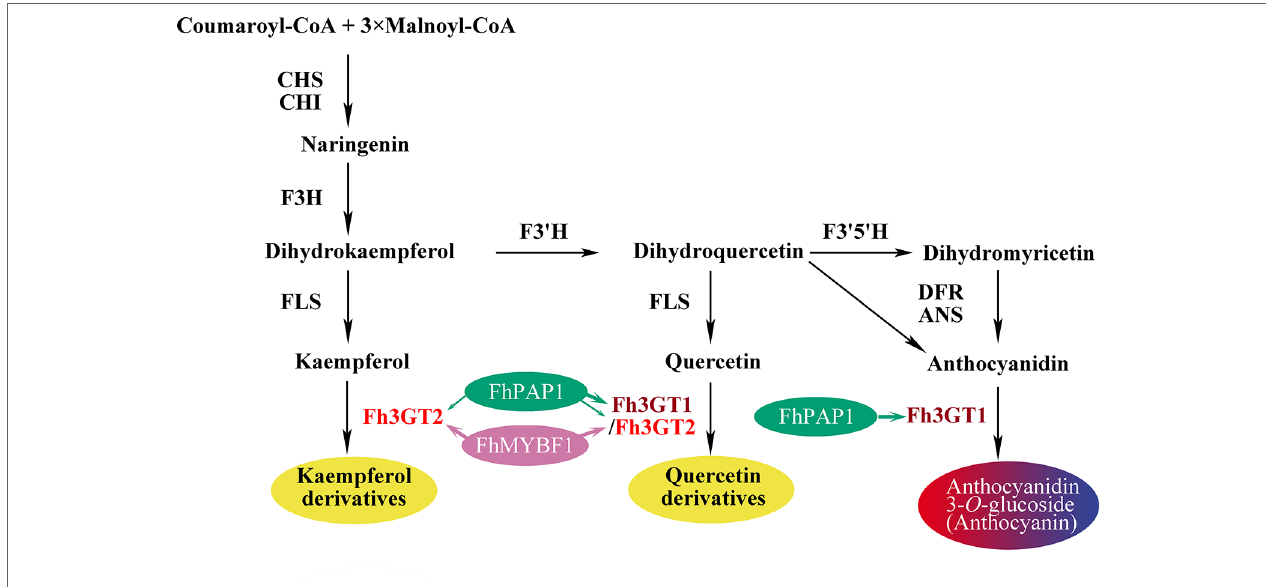
FIGURE 7 | Schematic diagram illustrating the roles of Fh3GT2 and Fh3GT1 in the flavonoid biosynthesis of Fressia hybrida . Fh3GT2 was mainly responsible for the glycosylation of kaempferol and quercetin, with different efficiencies, while Fh3GT1 preferred to glycosylate anthocyanidins and quercetin. Both Fh3GT2 and Fh3GT1 could be regulated by FhPAP1, with different efficiencies, whereas FhMYBF1 could only activate the expression of Fh3GT2 . CHS chalcone synthase, CHI chalcone isomerase, F3H flavanone 3-hydroxylase, F3’, 5’H flavonoid 3 ′ , 5'- hydroxylase , FLS flavonol synthase, DFR dihydroflavonol reductase, ANS anthocyanidin